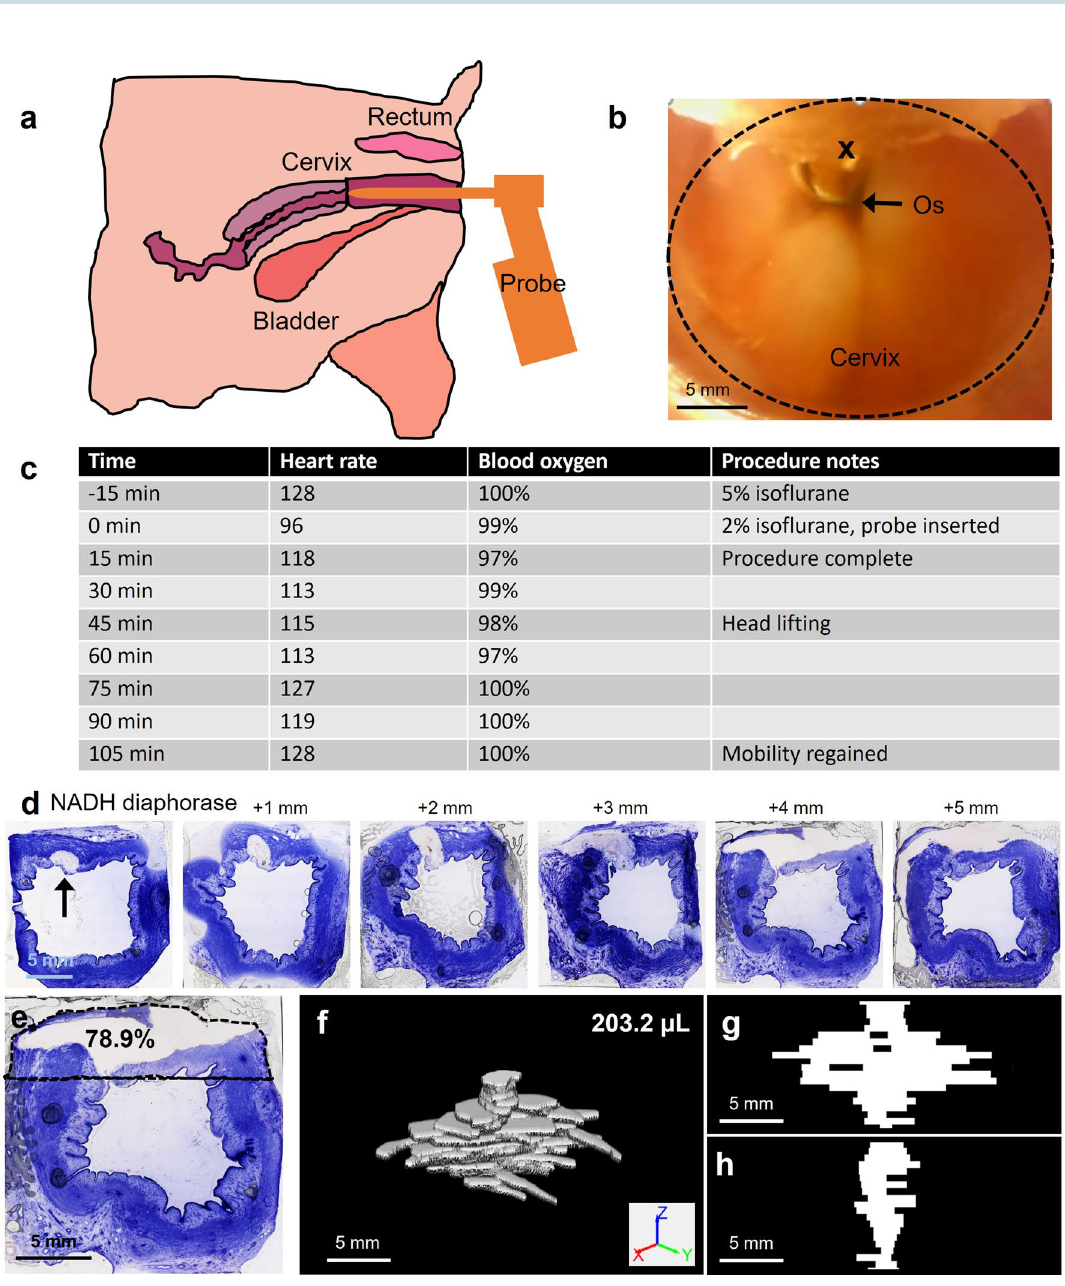
Figure 6. Feasibility of EC-ethanol injection in an in vivo swine cervix model (7.6 mm insertion depth, 10 mm/s insertion rate, 12% EC-ethanol, 10 mL/h infusion rate, 500 µL infusion volume). ( a ) Orientation of how our prototype injector was inserted into the vaginal canal and used to find ( b ) the cervical os. The cervix and injection location are indicated by a dashed black circle and black x respectively. ( c ) Heart rate and blood oxygen saturation were monitored throughout the procedure. Mobility was regained 90 min after the procedure was completed. ( d ) After 24 h the cervix was excised. Necrosis, seen as the region that did not stain blue with NADH diaphorase (and indicated by a black arrow in first image), could be clearly seen in the excised cervix. ( e ) At a 4 mm depth, the necrotic region covered 78.9% of the upper quadrant of the cervix (outlined by a black dotted line). ( f ) 3D rendering of reconstructed necrotic volume and slice through the center of the ( g ) XZ and ( h ) YZ planes. The volume of necrosis was 203.2 µL. Scale bars are 5